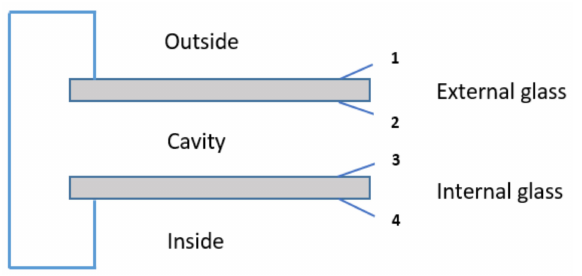
Figure 1. Surface numbering definitions at a double-glazed